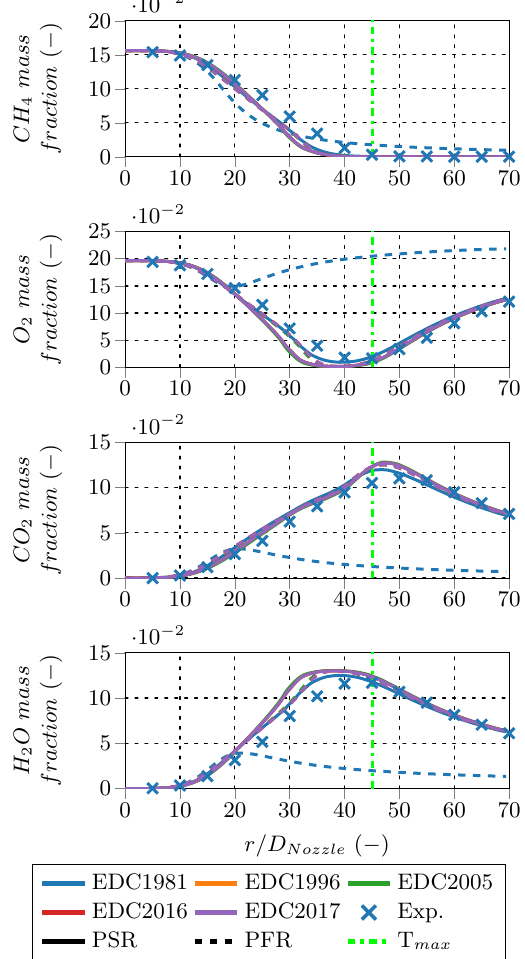
Figure 8. Centerline profiles of main species (CH 4 , O 2 , CO 2 , and H 2 O) mass fractions of flame D for all EDC model variations compared to the experimental data from [22]. Not all EDC versions are visible due to overlapping